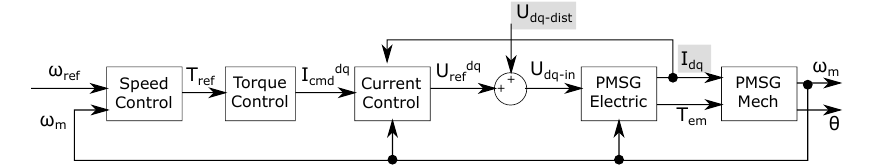
Figure 7. WT control block diagram.